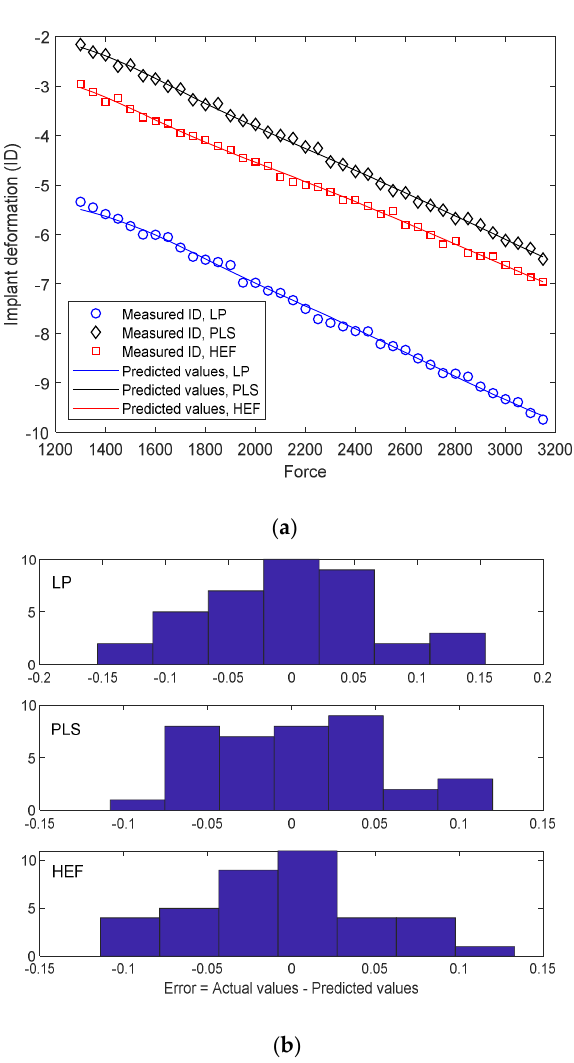
Figure 14. ID—actual values—ANN predicted values ( a ) and absolute error histograms ( b ). The mean value and standard deviation of error (absolute values) are presented in Table 5. Table 5. Mean and standard deviation of absolute error.